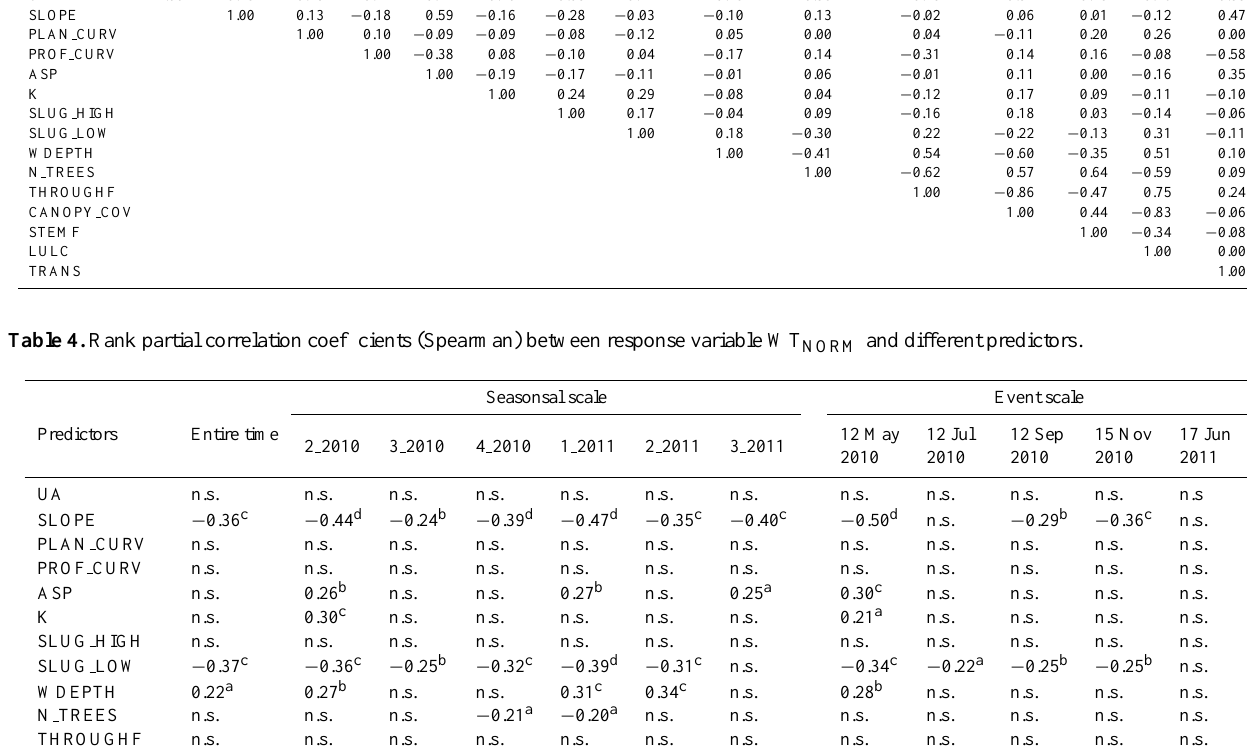
Table 3. Rank correlation coefficients (Spearman) between predictor variables. PLAN UA SLOPE